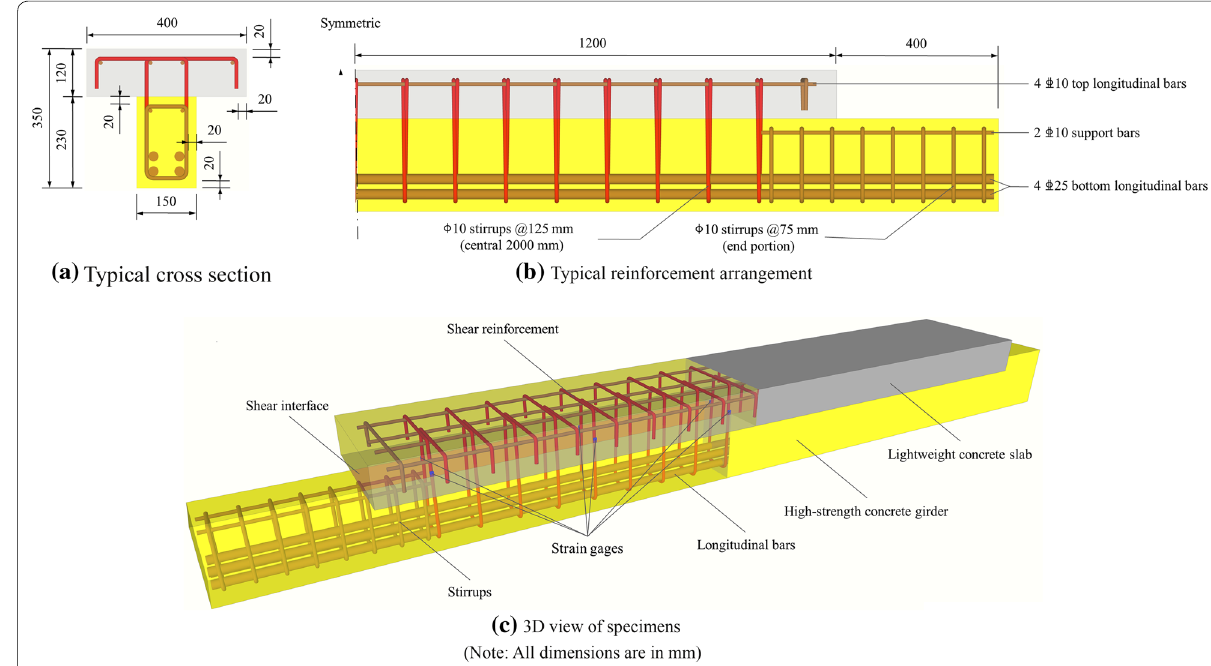
Fig. 1 Typical details of test